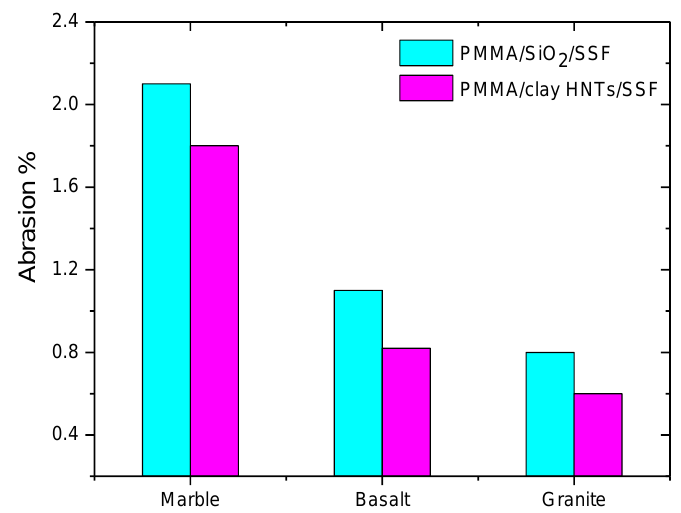
Figure 7. Effect of nanoparticle type on the abrasion percent of acrylic solid surface nanocomposite sheets.